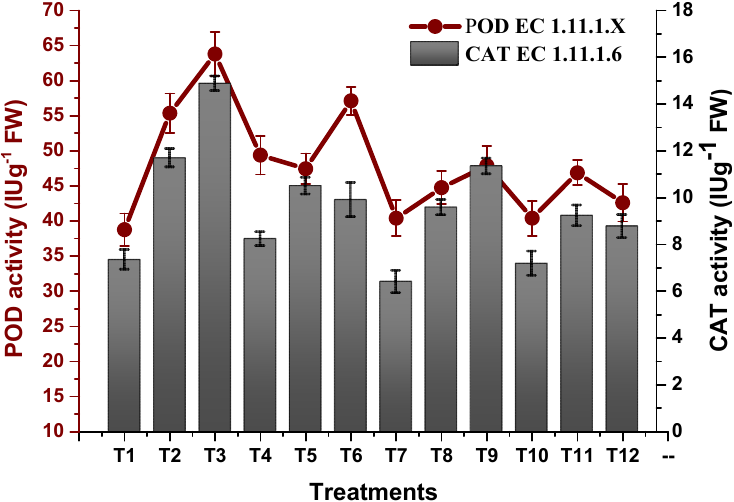
Figure 10. Effect of TU–ANPs on activities of peroxidase (POD) and catalase (CAT) of Zea mays under various levels of NaCl-based osmotic stress.